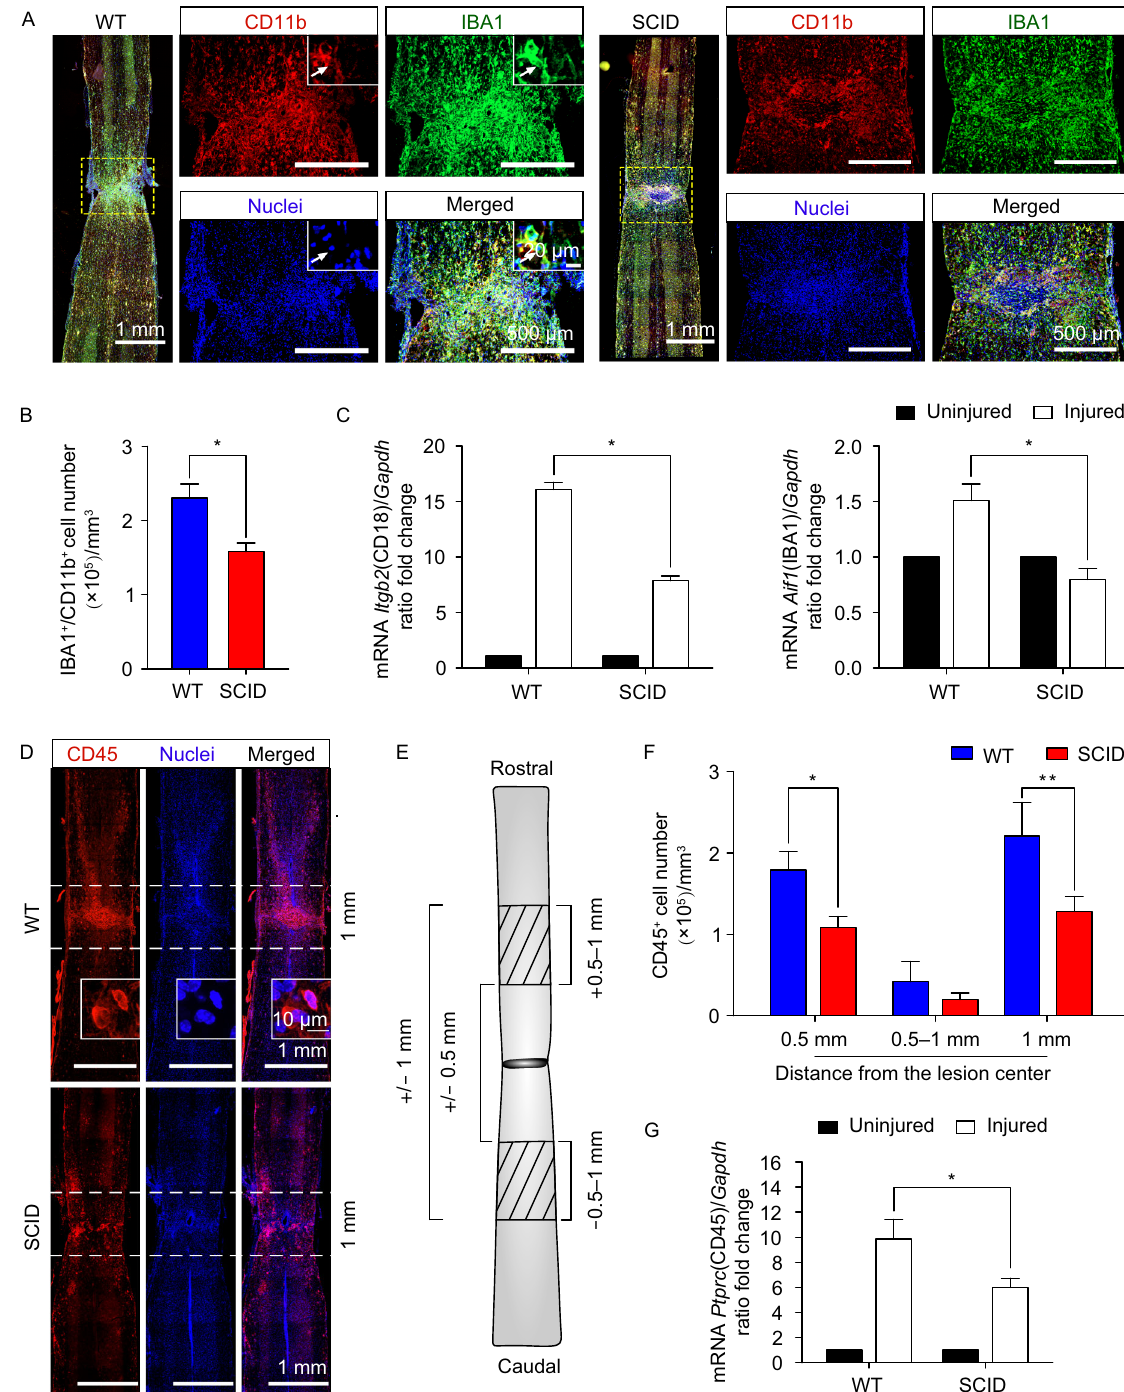
Figure 3. Dampened immune response in SCID mice after SCI. (A) Detection of microglia/macrophages in WTand SCID mouse spinal cord samples by IBA1 and CD11b immunostaining at 28 d post-injury. (B) Quanti fi cation of IBA1/CD11b double positive cells located within 1 mm of the spinal cord segment fl anking the epicenter. (C) qRT-PCR validation of expression of in fl ammation-related genes Itgb2 (CD18) and Aif1 (IBA1) in WT and SCID mouse samples. (D) Immunostaining of pan-leukocyte surface marker CD45 in WTand SCID mouse samples at 28 d post-SCI. (F) Unbiased stereological quanti fi cation of CD45 positive in fl ammatory leukocytes in the three regions illustrated in (E) (mean±SEM; n =4, * P <0.05, ** P <0.01, unpaired Student ’ s t -test). (G) qRT-PCR validation of Ptprc (CD45) gene expression in WT and SCID mouse